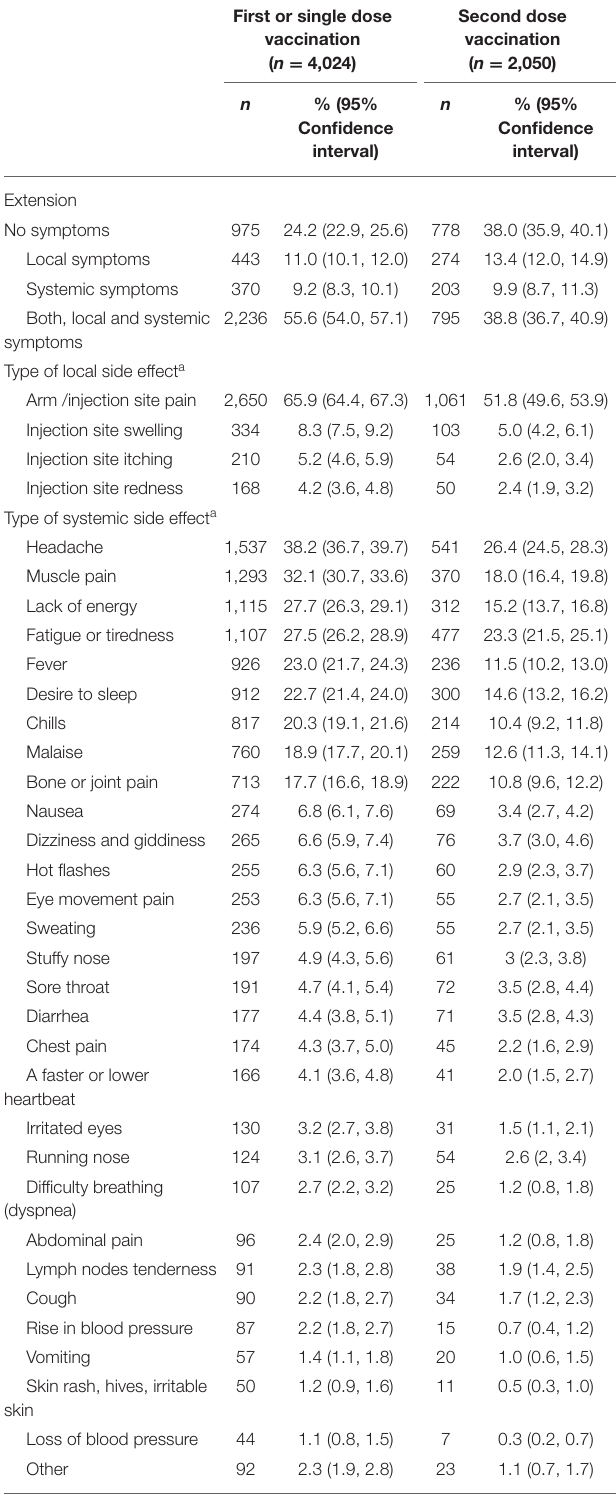
TABLE 3 | Extension of side effects by the number of